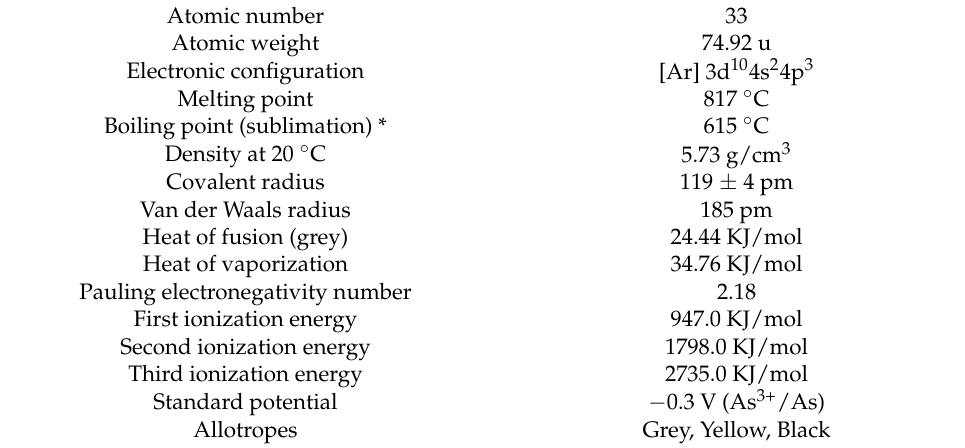
Table 1. Physicochemical properties of